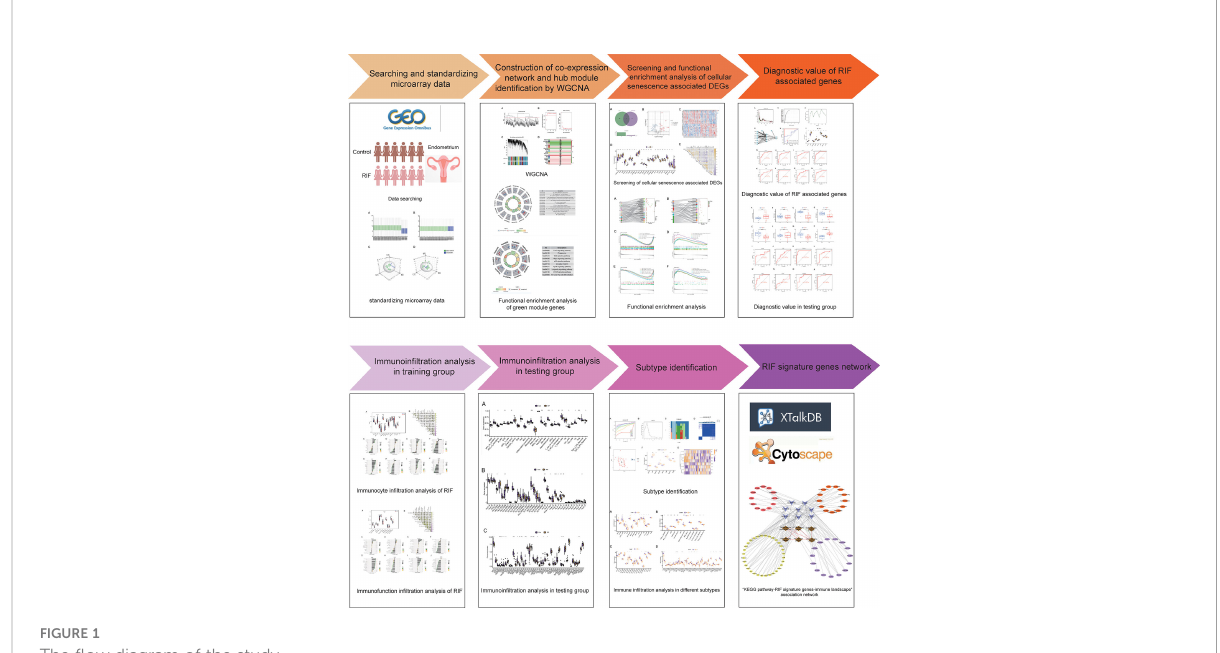
FIGURE 1 The fl ow diagram of the